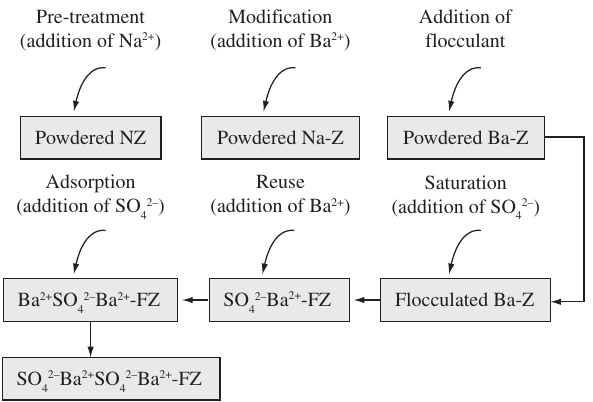
Figure 1. Staged reuse studies of saturated flocculated zeolites as “adsorbents”. (NZ: natural zeolite; Na-Z: pre-treated zeolite; Ba-Z: modified zeolite with barium ions; and FZ: flocculated